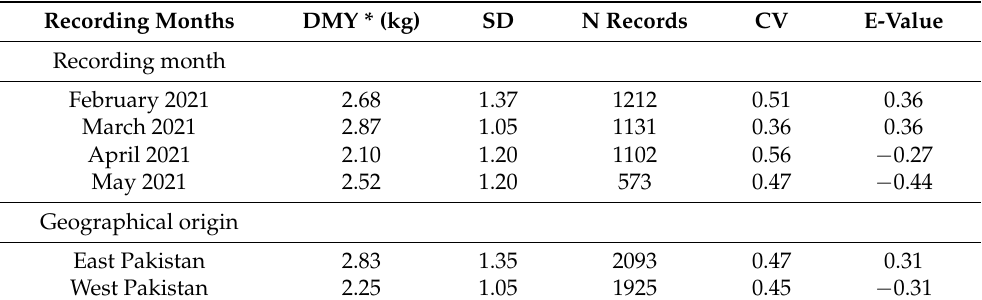
Table 1. The mean of daily milk yields, standard deviation, coefficient of variation, number of records, and estimated value of repeatability model for recording months and geographical origins of